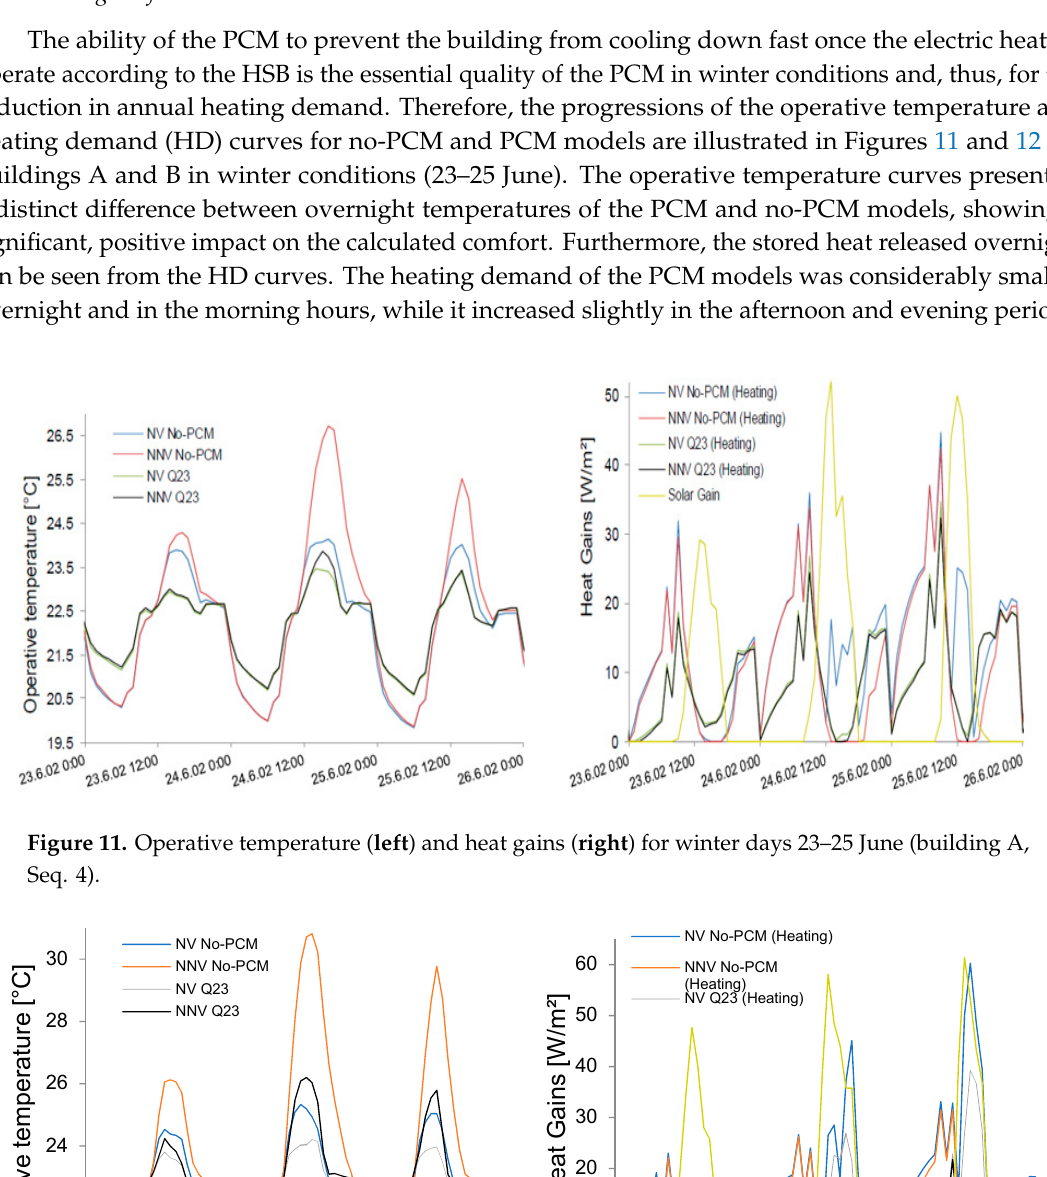
Figure 13. Annual energy savings as a percentage for different equipped surfaces of building B. From Figure 11, it can be seen that applying PCM on the roof led to the highest annual energy savings when PCMs were only used on one structure component. This applies to building A as well. Although the annual energy savings for the case “all SCs” was considerably higher than that achievable by one single SC, the benefits were still significant. For instance, the maximum savings for a single structure component (roof) reached 11.42 kW·h/m². This is equivalent to a total of 713.75 kW·h energy saved per annum for the whole building. Since just over 3600 kW·h was consumed per